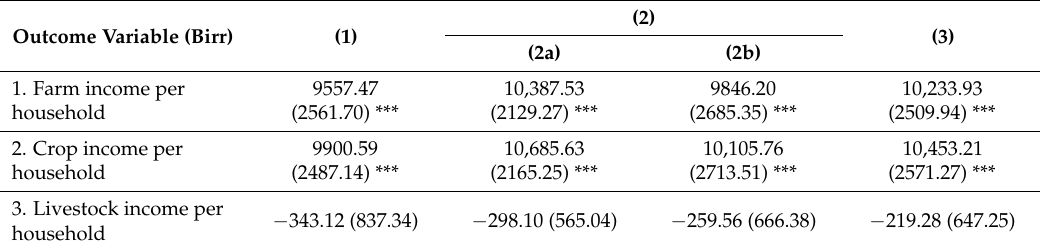
Table 5. Estimation of average effect of training on outcome variables using nearest neighbours, kernel and radius